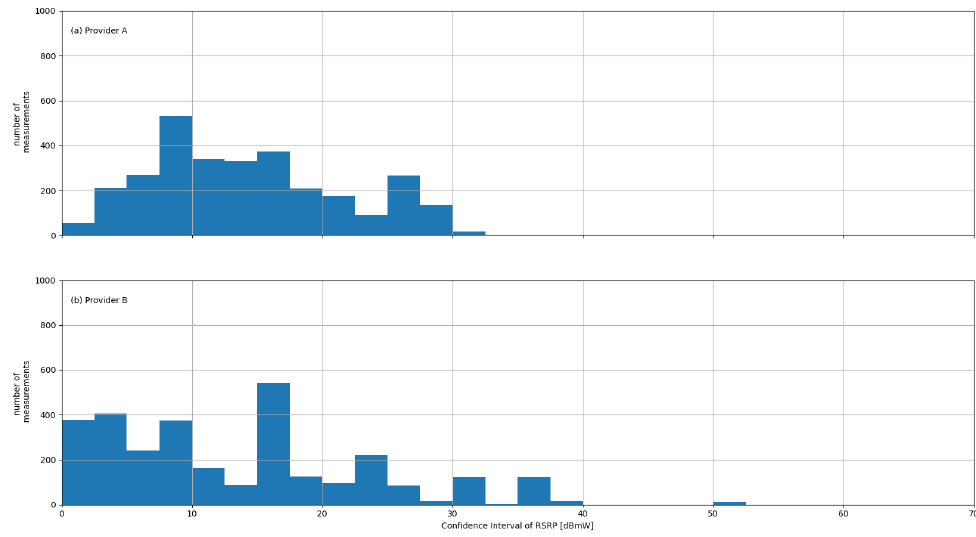
Figure 8. Histogram of the confidence intervals for RSRP.